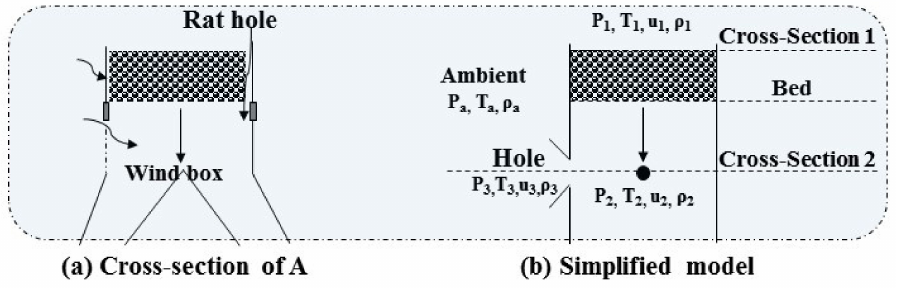
Figure 3. Cross-section of region A and simplified